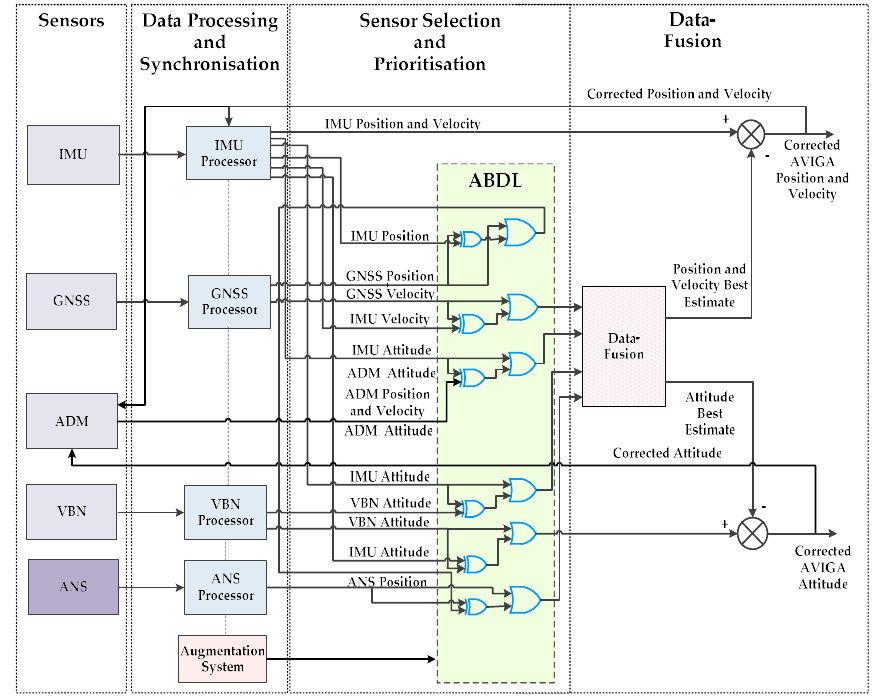
Figure 13. AVIGA Figure 13. AVIGA architecture.